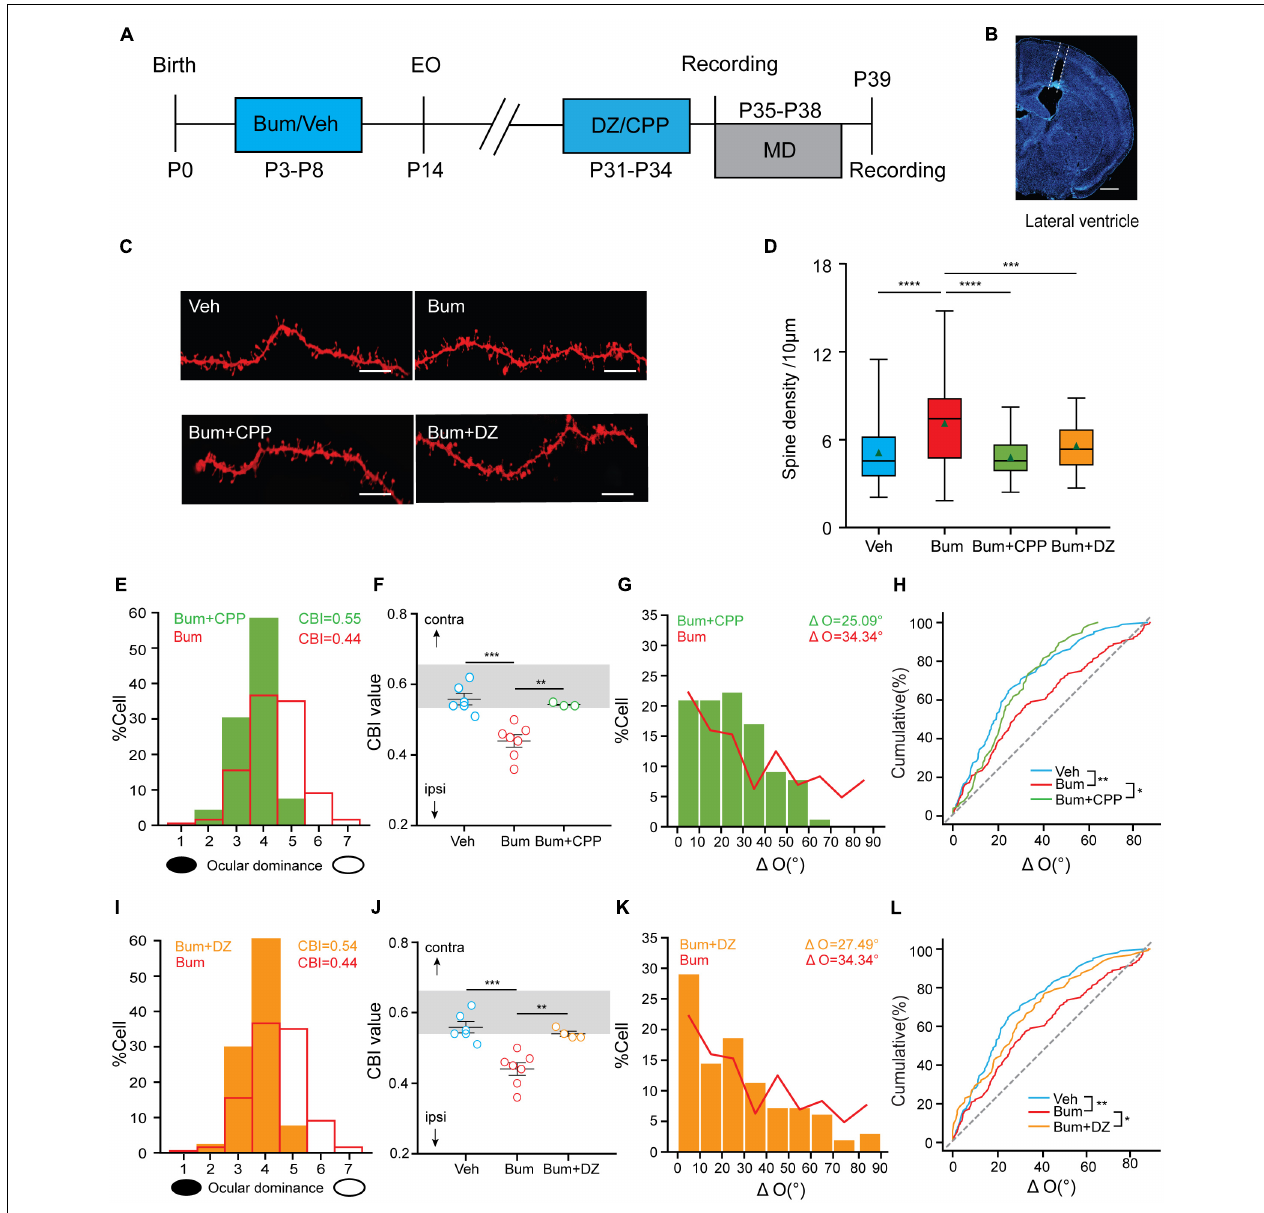
FIGURE 7 | Diazepam/[(R, S)-3-(2-carboxypiperazin-4-yl) propyl-1-phosphonic acid (CPP)] restores the extended OD plasticity and rescues the mismatching deficit in Bum mice. (A) Schematic of experimental design. (B) Image showing traces of cannula in lateral ventricle, scale bar, 500 µ m. (C) Representative images of DiI dye staining of lateral branches of apical dendrites at P35 in Veh and Bum, Bum + CPP and Bum + diazepam (DZ) mice. Scale bar, 10 µ m. (D) Spine density at P35 Bum (7.14/10 µ m) was significantly higher than age-matched Veh (5.14/10 µ m, 58 dendrites, four mice), Bum + CPP (4.81/10 µ m, 56 dendrites, four mice), and Bum + DZ (5.6/10 µ m, 49 dendrites, four mice). The data are summarized by a box chart, and the horizontal lines in the box denote the 25th, 50th, and 75th percentile values. The error bars denote the 5th and 95th percentile values. The green triangle symbol indicates the average value. p = 0.0006, Bum vs. Bum + DZ; p < 0.0001, Veh vs.Bum; p < 0.0001, Bum vs. Bum + CPP; p = 0.28, Bum + CPP vs. Bum + DZ. (E,F) Administration of CPP restores the extended OD plasticity. (E) CPP blocked the OD shift in Bum mice at P35 (green histogram). The red solid line represents the OD distribution of Bum mice with 4 days MD. (F) OD plasticity was quantified by the values of CBI (Veh: 0.56 ± 0.015, six mice; Bum: 0.44 ± 0.016, seven mice; Bum + CPP: 0.55 ± 0.027, three mice; p = 0.0002, Veh vs. Bum; p = 0.0066, Bum vs. Bum + CPP; open circles represent individual CBIs for each animal, One-way ANOVA with Tukey’s post hoc test). The gray box indicates the typical range of CBI values for non-deprived mice. (G) Distribution of the difference in orientation preference in Bum + CPP ( (cid:49) O = 25.09 ± 1.83 ◦ , 75 cells, five mice). The red solid curve represents the (cid:49) O distribution of Bum ( (cid:49) O = 34.34 ± 2.15 ◦ , 142 cells, 14 mice). (H) Cumulative distribution of (cid:49) O in Bum + CPP, Bum, and Veh ( (cid:49) O = 24.26 ± 1.54 ◦ , 102 cells, nine mice. p = 0.0035, Veh vs. Bum; p = 0.30, Veh vs. Bum + CPP; p = 0.046, Bum + CPP vs. Bum, K-S test). (I,J) the same as (C,D) administration of DZ restores the extended OD plasticity in Bum mice (Bum + DZ: 0.54 ± 0.006, four mice; p = 0.0002 Veh vs. Bum; p = 0.0031 Bum vs. Bum + DZ). (K) The same as (E) in Bum + DZ ( (cid:49) O = 27.49 ± 2.30 ◦ , 94 cells, five mice). (L) The same as (F) in Bum + DZ, Bum, and Veh groups ( p = 0.42, Veh vs. Bum + DZ; * p < 0.05, ** p < 0.01, *** p < 0.001, **** p < 0.0001, Bum + DZ vs. Bum). P35 for binocular matching; P35 + 4d MD for ocular dominance plasticity. Data were expressed as mean ± SEM except for box